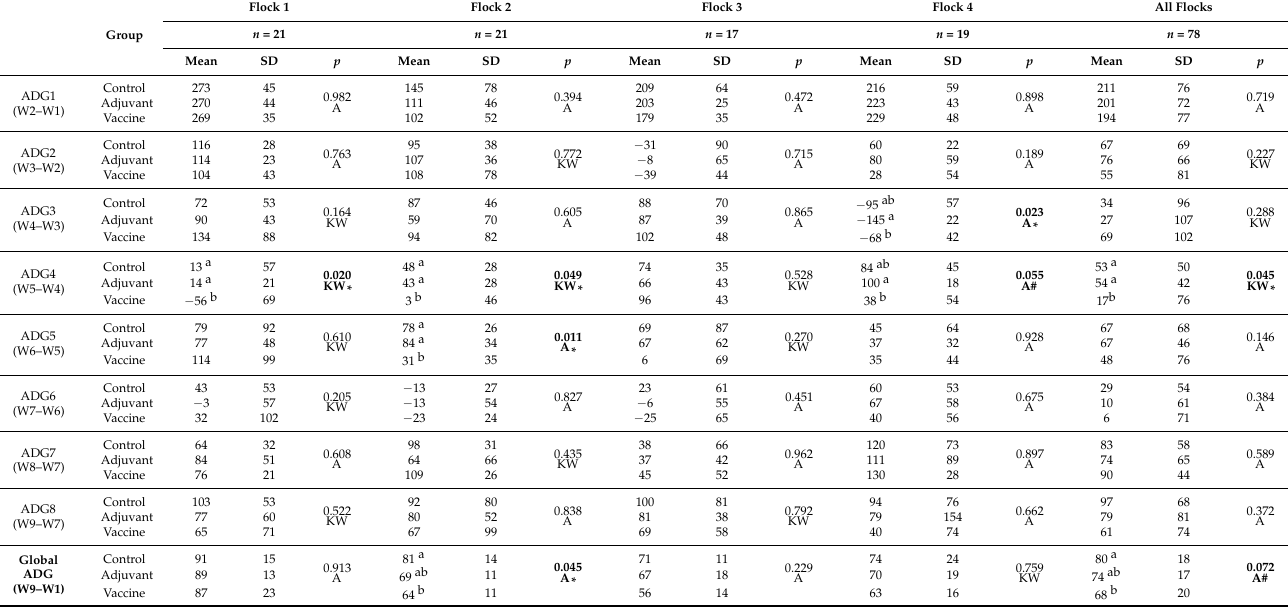
Table A13. Average daily gain (ADG) between weighing dates (W) along the experiment in Control, Adjuvant-only, and Vaccine groups in each of the four flocks individually (Flocks 1–4) and all flocks grouped together (All Flocks). Data represented as mean and standard deviation (SD).